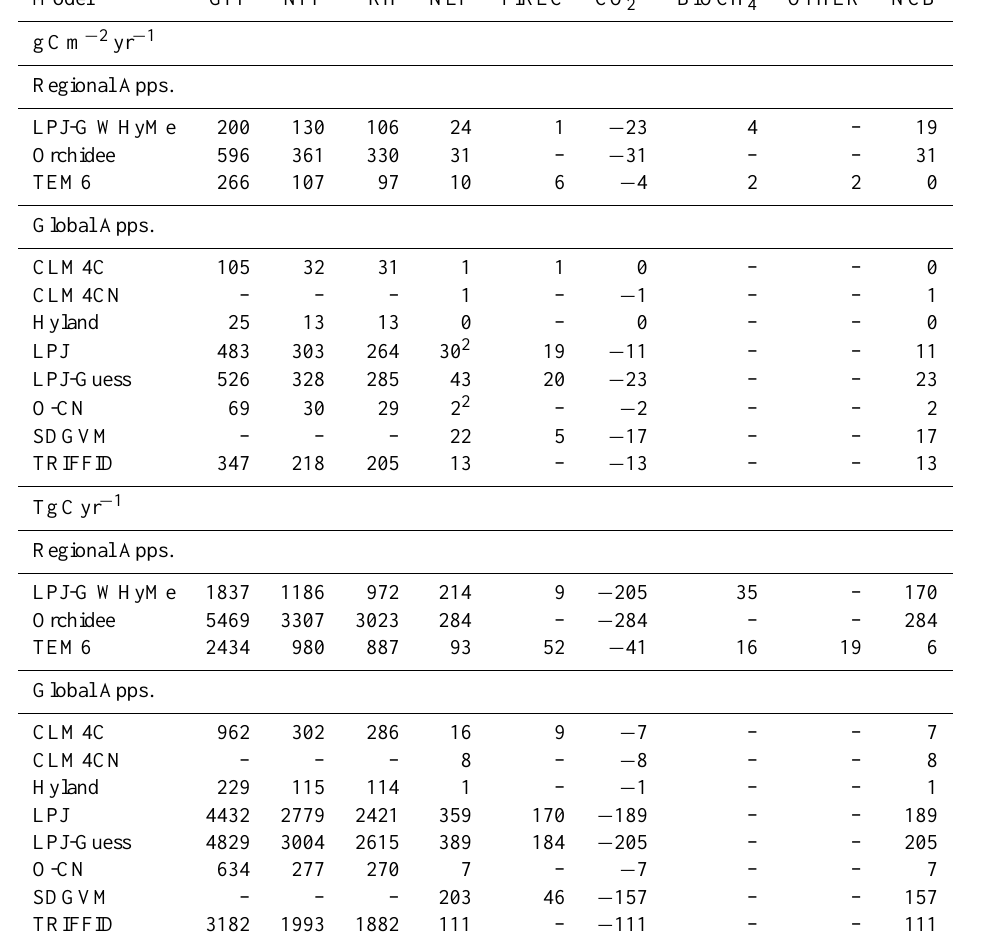
Table 7. Mean C budget of Arctic tundra simulated by process models for 1990–2006.